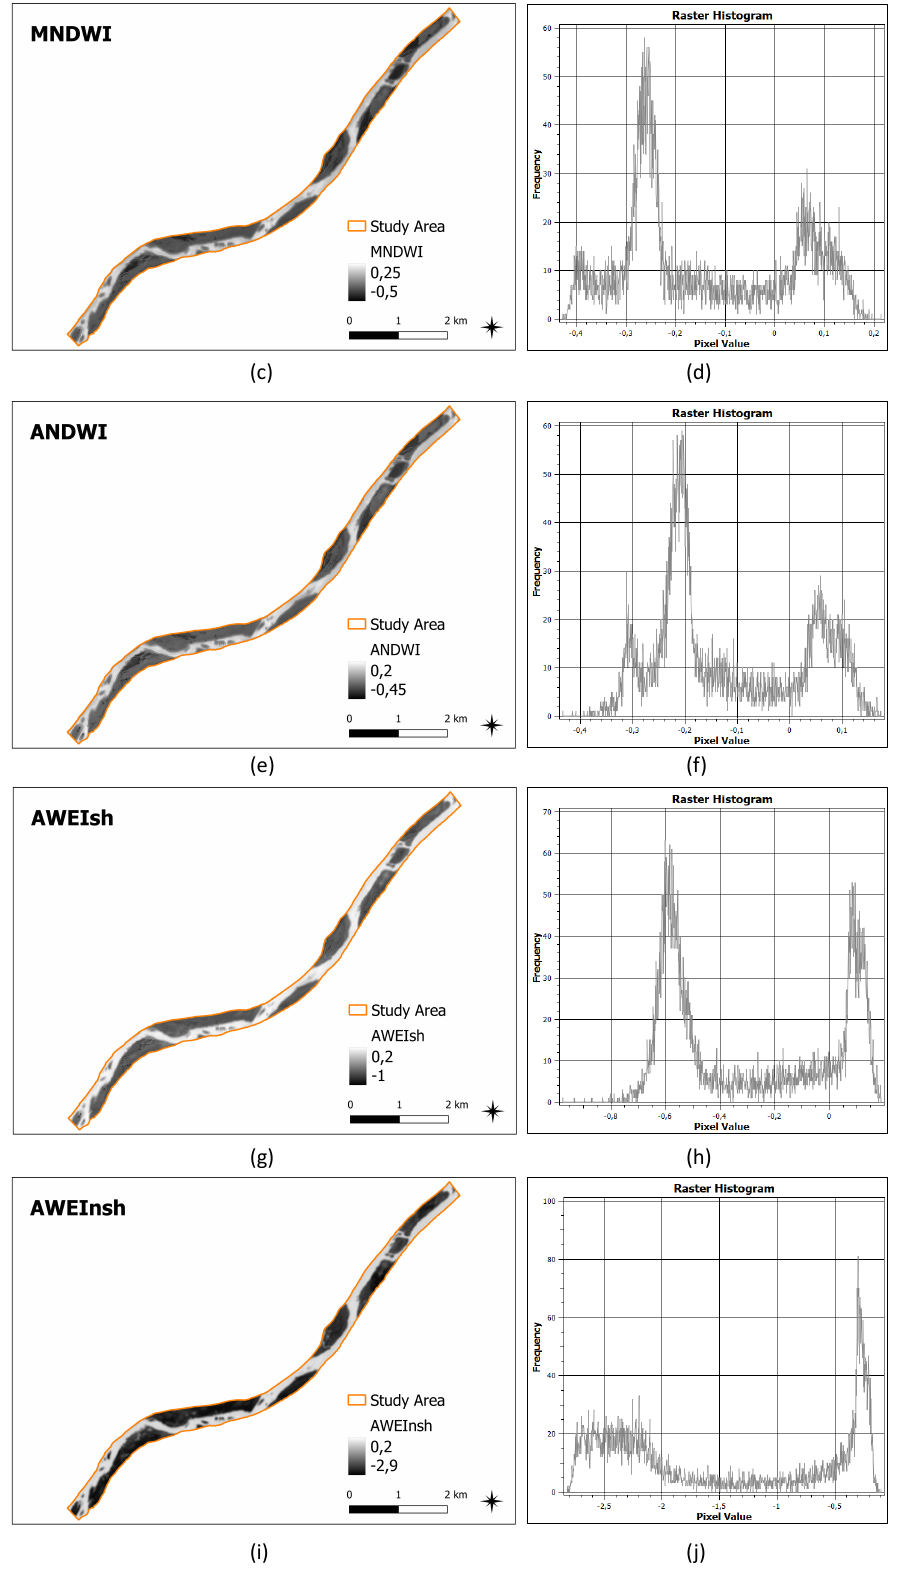
Figure 4. Using Sentinel-2 imagery. ( a , c , e , g , i ) Spectral water indices maps of a segment of the Tagus River (Portugal) for NDWI, MNDWI, ANDWI, AWEIsh, and AWEInsh; the darker colors indicate non-water features. ( b , d , f , h , j ) Corresponding data histograms. The data spatial resolution is 20 m. The date of observation was 8 July